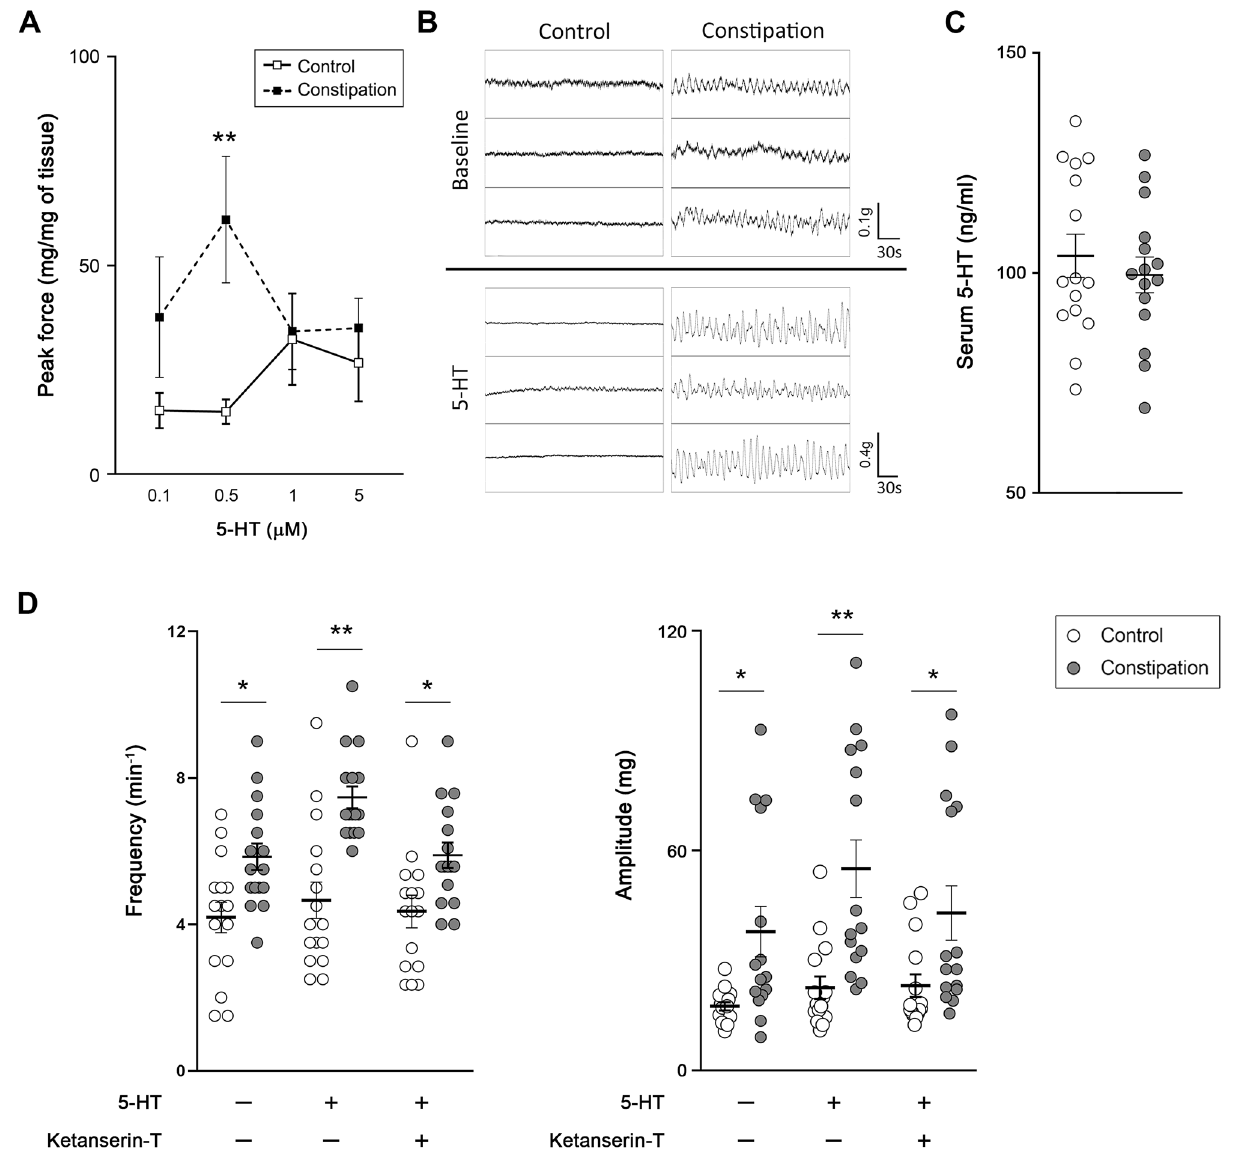
Figure 7. The effect of 5-HT on the bladder strips. ( A ) Peak contractile force in response to 5-HT. ( B ) Representative traces of basal activity of the bladder strips from each group before and after incubation with 0.5 µM 5-HT (upper and lower panels, respectively). ( C ) Serum 5-HT level from each group. the amplitude, and the frequency of spontaneous contractions of the bladder strips. D, the frequency (left) and amplitude (right) of spontaneous contractions of the bladder strips in presence or absence of 5-HT and ketanserin (Htr2 antagonist). Open and grey circles represent the control and the constipation groups (n = 16 per group), respectively. Mean ± SE, *p < 0.05, **p < 0.005 between the groups. Figures were prepared using Adobe Photoshop CS6 and GraphPad Prism 8.4.3 (https ://www.graph pad.com/scien tific -softw are/prism